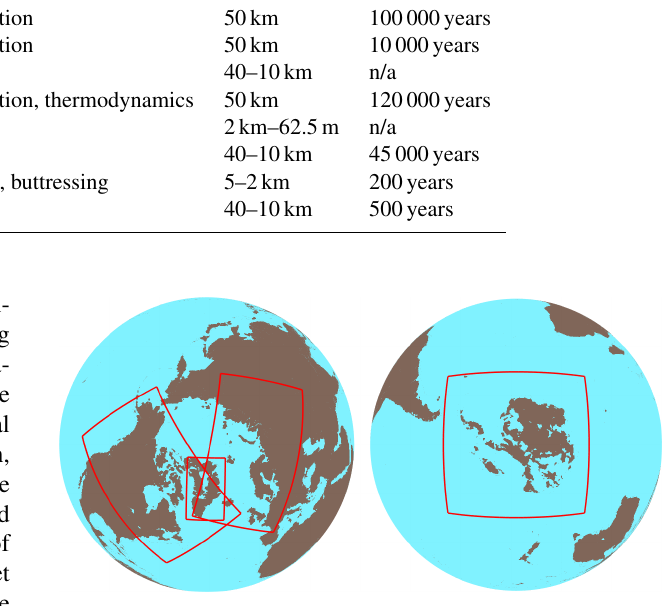
Figure 1. The four model regions of IMAU-ICE. No ice is shown; brown (blue) indicates bedrock above (below) present-day sea